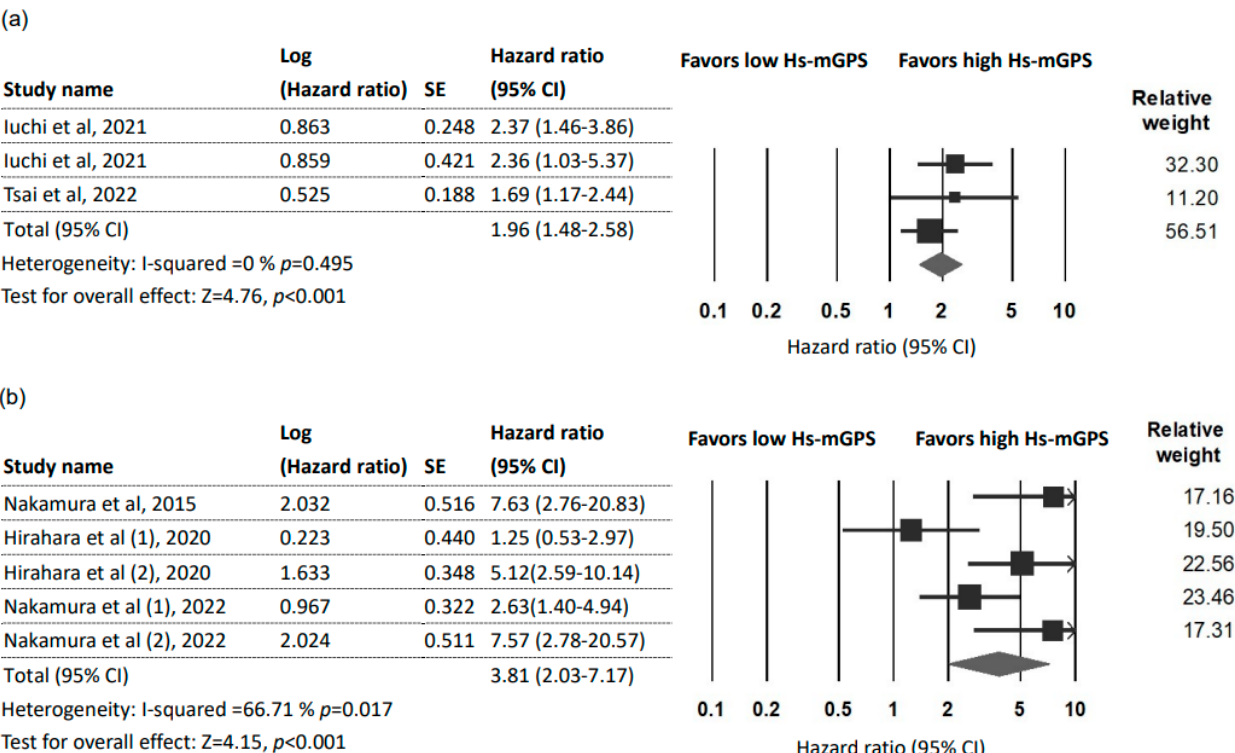
Figure 3. Forest plot indicating the pooled HRs to assess the influence of the HS-mGPS. ( a ) The influence of the HS-mGPS on DFS; ( b ) The influence of the HS-mGPS on DSS. Abbreviations: HR, hazard ratio; CI, confidence interval; HS-mGPS, high-sensitivity modified Glasgow Prognostic Score [7,21,26,27,31,33].